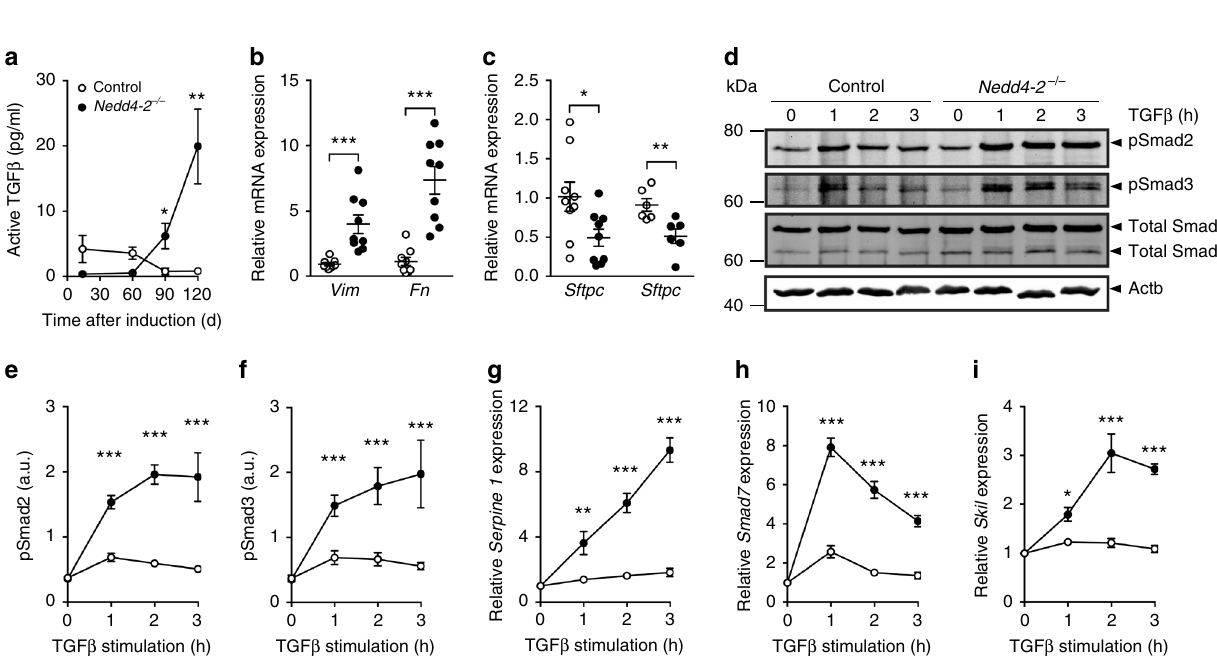
Fig. 6 Conditional deletion of Nedd4-2 in lung epithelial cells causes increased levels of TGF β and exaggerated Smad2/3 signaling. a Levels of active TGF β in whole lung of conditional Nedd4-2 − / − mice and littermate controls after 0.5 ( n = 4/group), 2 ( n = 4/group), 3 ( n = 5/group), and 4 months ( n = 6/group) of doxycycline induction. b , c mRNA expression levels of the mesenchymal marker genes Vim and Fn1 ( n = 9/group) ( b ) and alveolar type 2 (AT2) cell markers Sftpc ( n = 9/group) and Sftpd ( n = 6/group) ( c ) of whole lungs from conditional Nedd4-2 − / − and control mice after 3 months of doxycycline induction. d – i AT2 cells isolated from conditional Nedd4-2 − / − and control mice induced with doxycycline for 2 weeks were pretreated with 1 ng/ml TGF β and analyzed for phosphorylated Smad2/3 (pSmad2/3) and transcript levels of TGF β -inducible genes. d – f Representative Western blot ( d ) and densitometric analysis of pSmad2 ( e ) and pSmad3 ( f ) at baseline and after 1 – 3 h of TGF β stimulation. g – i mRNA levels of Serpine1 ( g ), Smad7 ( h ), and Skil ( i ) after the indicated time of TGF β stimulation. All in vitro data are derived from 3 independent experiments. * P < 0.05, ** P < 0.01, *** P < 0.001 compared to controls. Statistical analysis was performed using two-tailed Mann – Whitney test in a , b , two-tailed unpaired t test in c , and two-way ANOVA wi t h Sidac ’ s post hoc test in e – i . Data are shown as mean ± S.E.M. Source data are provided in the Source Data fi